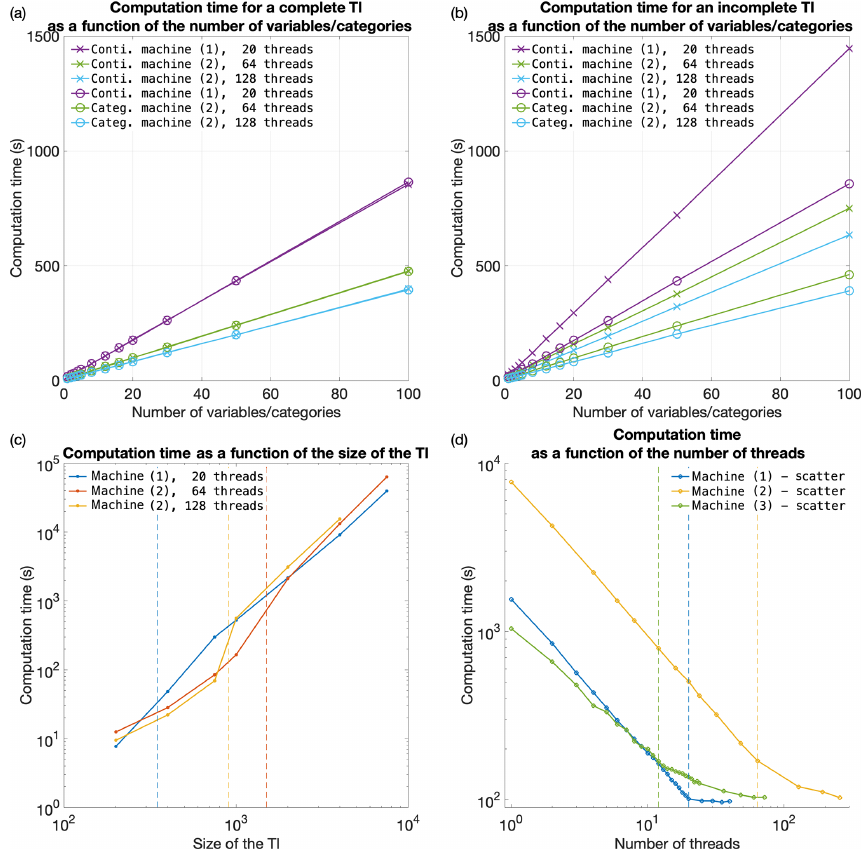
Figure 9. Efficiency of QS with respect to all key parameters. Panels (a) and (b) are the evolution of the computation time for complete and incomplete training images, respectively, with continuous and categorical variables. Panel (c) shows the evolution of the computation time as the size of the training image is varied; the dashed lines indicate that the training image no longer fits in the CPU cache. Panel (d) shows the evolution of the computation time as the number of threads is increased. The dashed lines indicate that all physical cores are used.